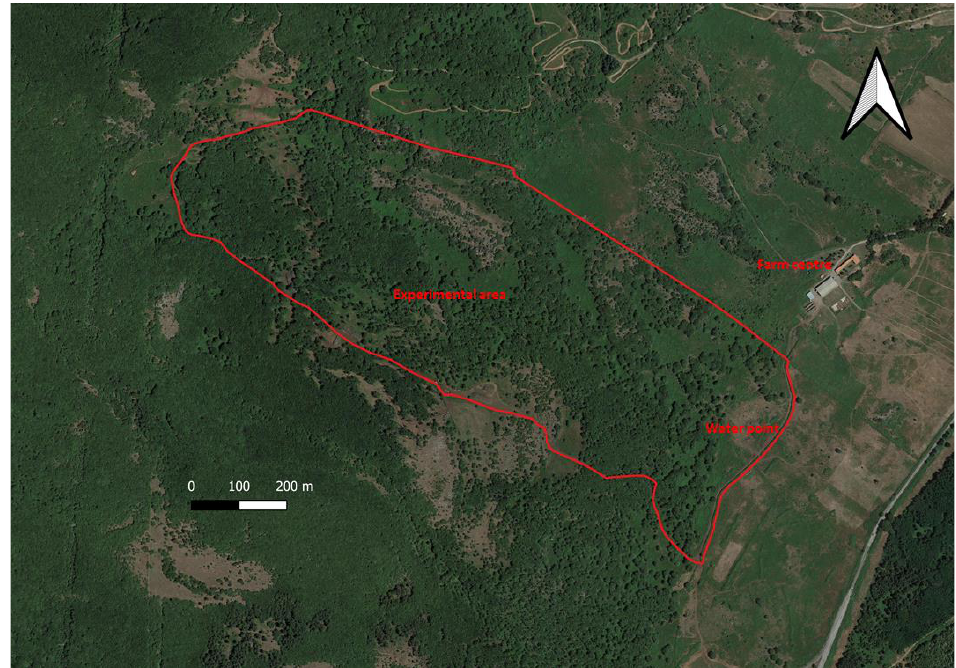
Figure 1. Experimental area. Table 1. Maximum (T max), minimum (T min), average temperature (T avg) (mean ± s.d.) and rainfall patterns (total rainfall, mm) during the experimental periods. Experimental Periods T max T min T avg Rainfall